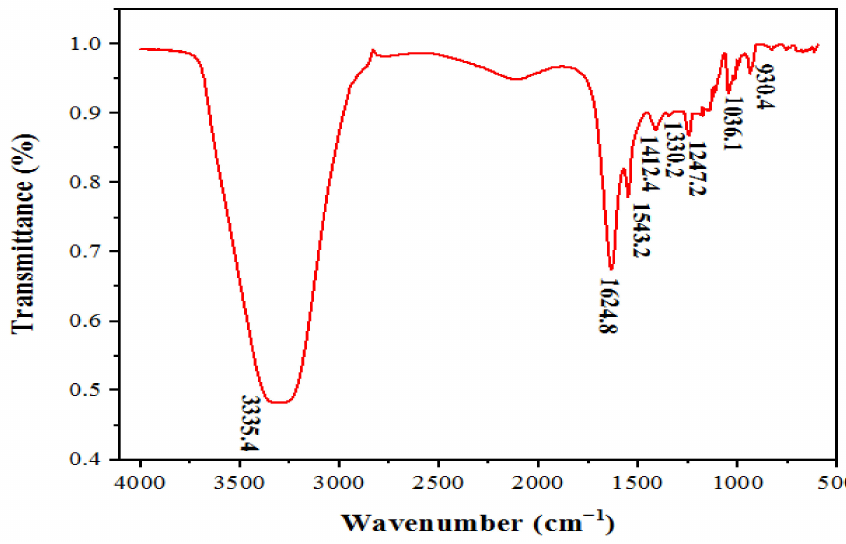
Figure 5. FTIR of Mn 2+ :ZnS